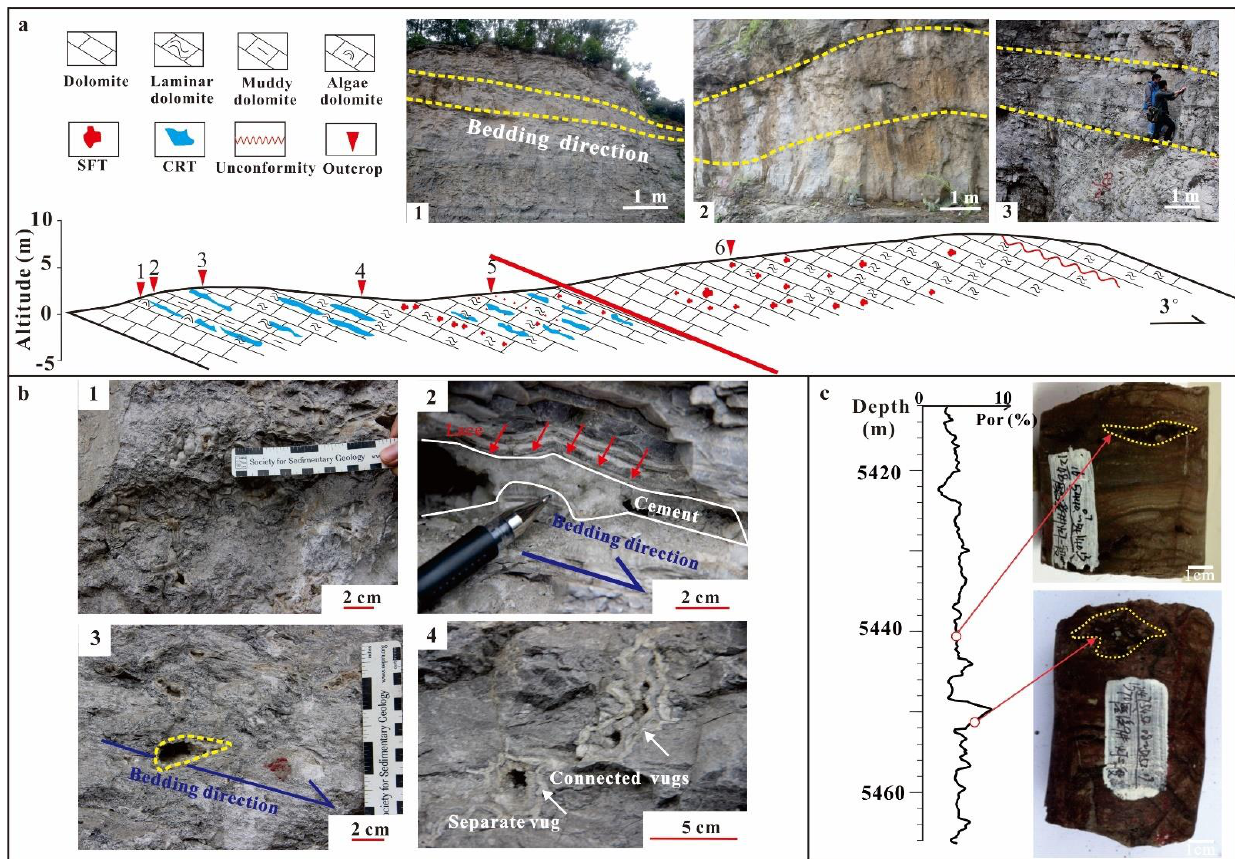
Figure 3. Features of solution-filling type (SFT) and cement-reducing type (CRT) in Deng #2 observed from outcrops. ( a ) Along-bedding distribution of solution-filling type (SFT) and cement-reducing type (CRT). The cement-reducing type (CRT) (left) and solution-filling type (SFT) (right) are distributed in the lower and upper Deng #2 member, respectively; ( b ) morphology of cement-reducing type (CRT); ( c ) filling features of the cement-reducing type (CRT).